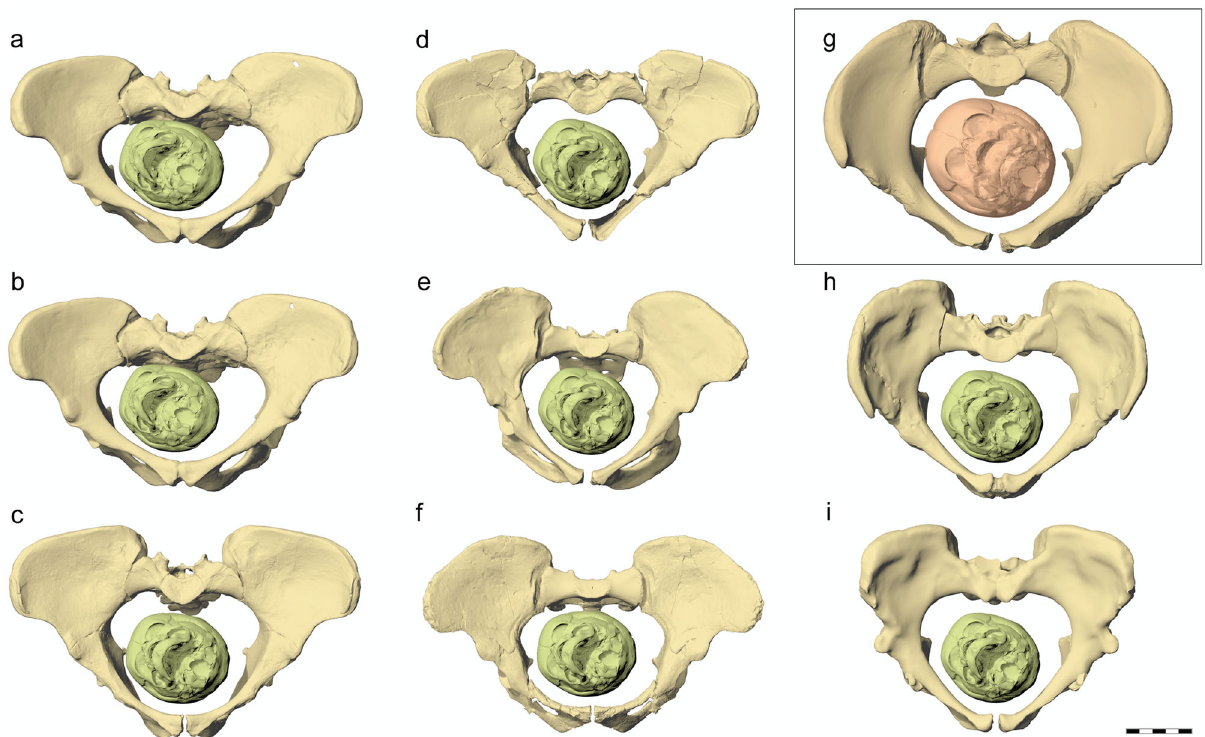
Fig. 3 Australopithecine pelvic reconstructions with a 110 g fetal head size engaged in the pelvic inlet, including A.L. 288-1 ( Australopithecus afarensis ), Sts 14 ( A. africanus ), and MH2 ( A. sediba ), compared with an average sized modern human female pelvis and fetal head. A.L. 288-1: a Lovejoy et al. 29 , b Tague and Lovejoy 18 , c Häusler and Schmid 19 , d Brassey et al. 20 ; Sts 14: e Häusler and Schmid 19 , f Berge and Goularas 17 ; g modern human female pelvis and fetal head (in inset); MH2: h Kibii et al. 21 , i Laudicina et al. 22 . All pelves are seen in a view perpendicular to the pelvic inlet. Scale bar 5 cm.